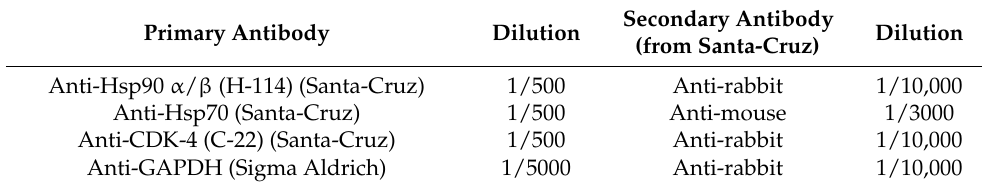
Table 3. Informations concerning antibodies used during this